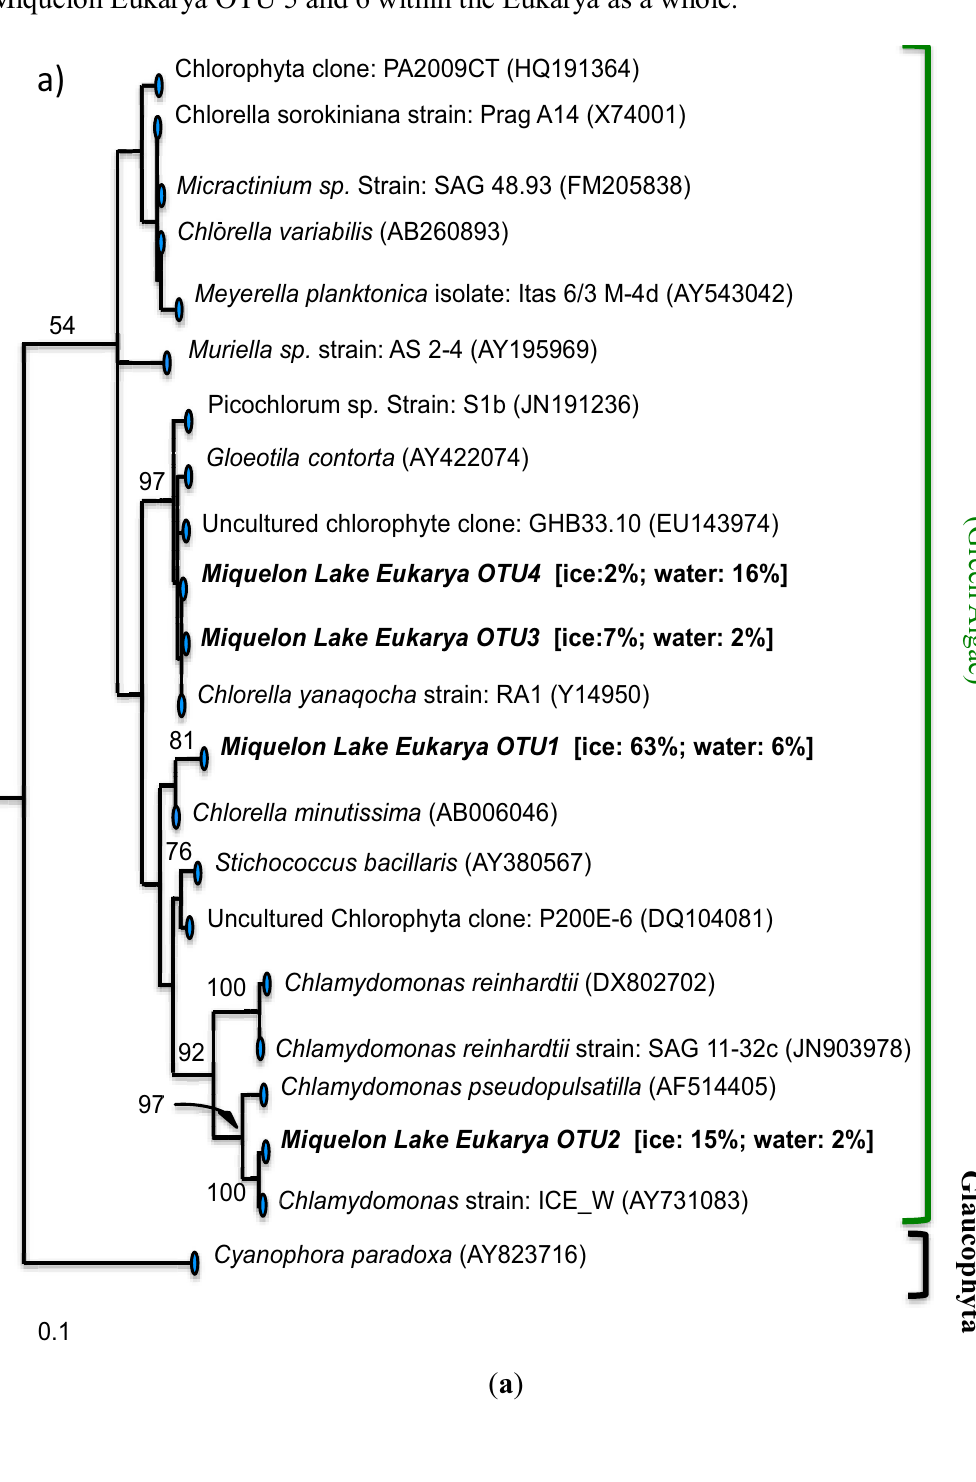
Figure 8. Maximum likelihood phylogenetic tree of Eukarya 18S rRNA genes from Miquelon Lake water and ice and relatives from the Genbank database. Scale bar represents 1 nucleotide change for each 10 nucleotides of sequence. Bootstrap support greater than 50 (of 100 replicates) is shown at nodes. Accession numbers for publically available sequences are given in parentheses. Miquelon Lake OTU are shown in bold; the relative abundance in the ice and water clone libraries is shown in brackets. ( a ) Detail showing relationships of Miquelon Eukarya OTU 1-4 within the Chlorophyta (green algae). ( b ) Phylogenetic position of Miquelon Eukarya OTU 5 and 6 within the Eukarya as a